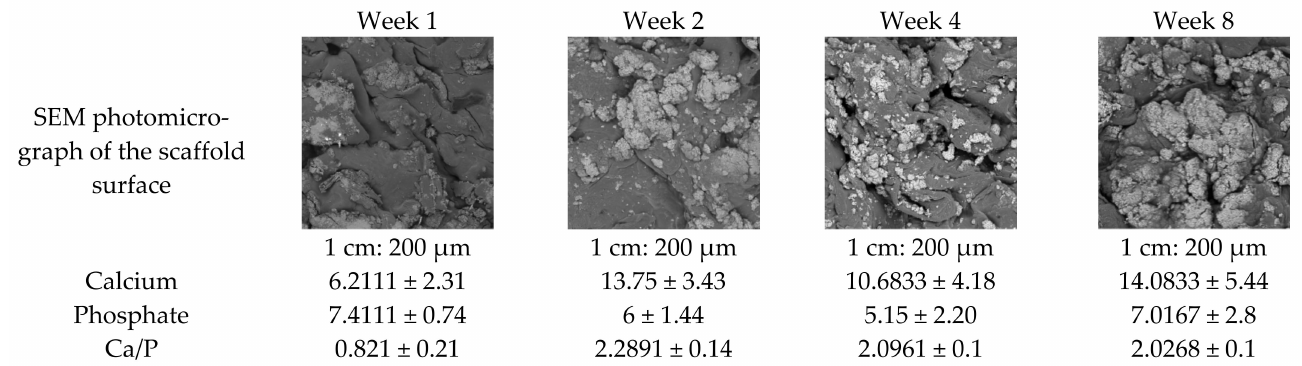
Figure 13. SEM-EDX analysis for the degraded CS/HAp scaffolds in weeks 1 to 8, showing a low Ca/P value in week 1 before increasing in week 2 and decreasing gradually to week